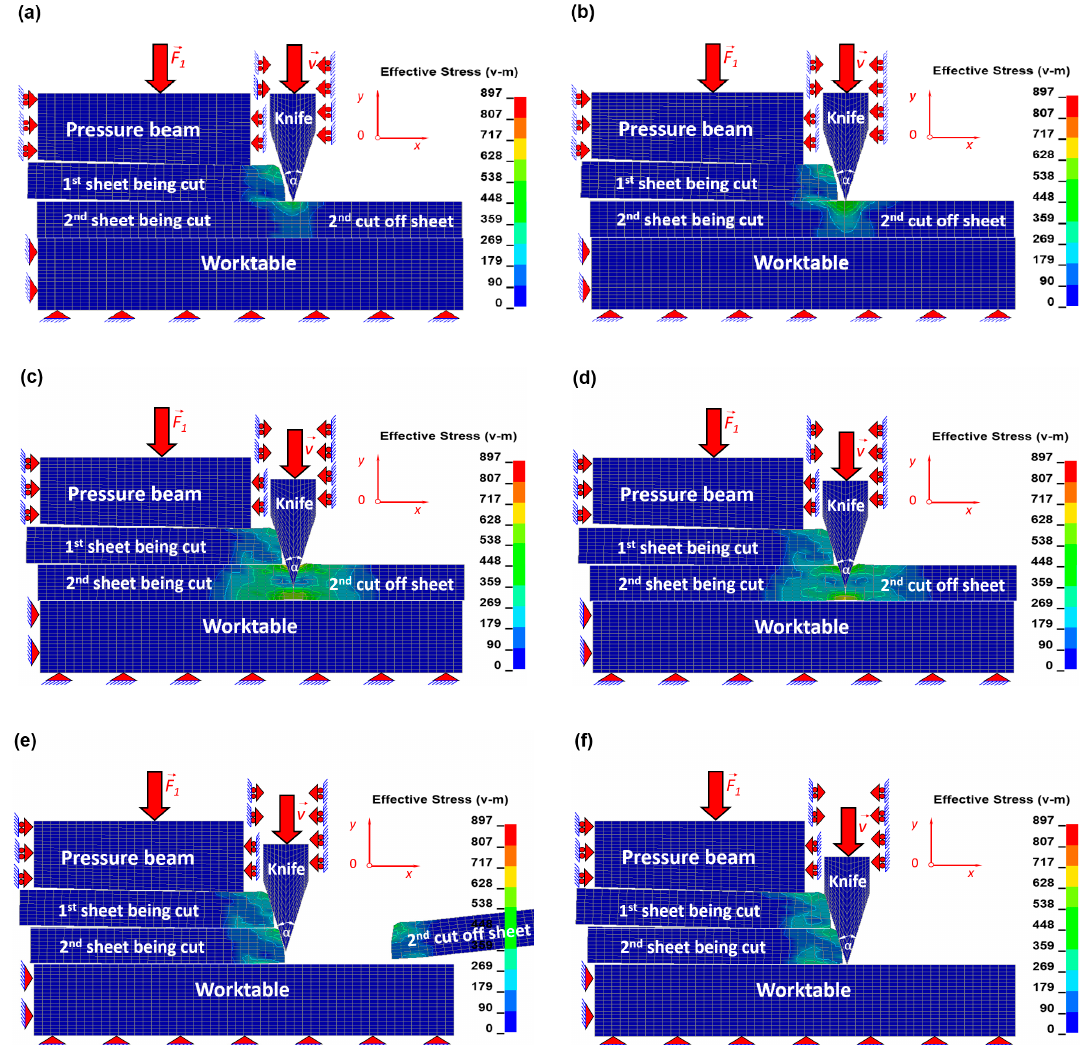
Figure 5. Contour maps of equivalent Huber–Mises stress [MPa] in the bottom sheet in a bundle being cut for the chosen time instants [ms]: ( a ) t = 12.04, ( b ) t = 12.07, ( c ) t = 18.00, ( d ) t = 18.35, ( e ) t = 18.43, ( f ) t = 22.00.